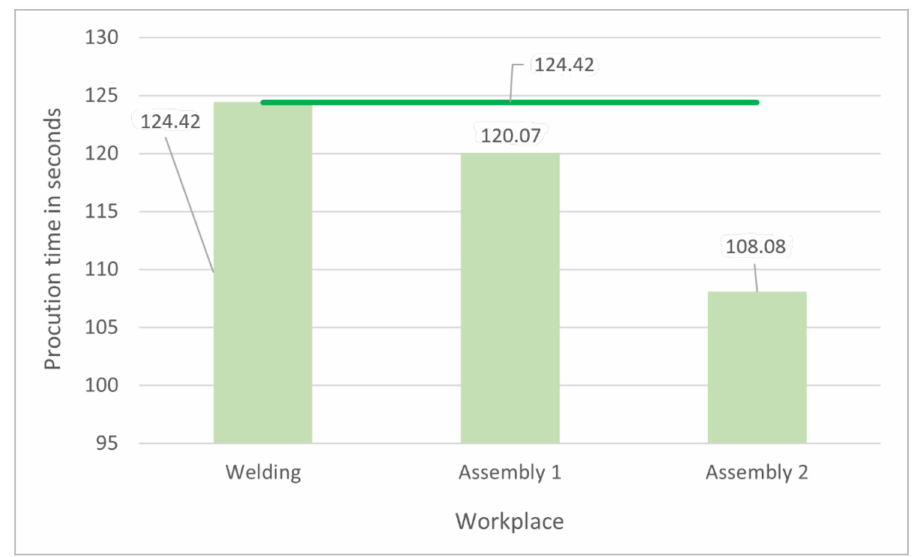
Figure 6. Proposed balance of production times of production line workplaces.